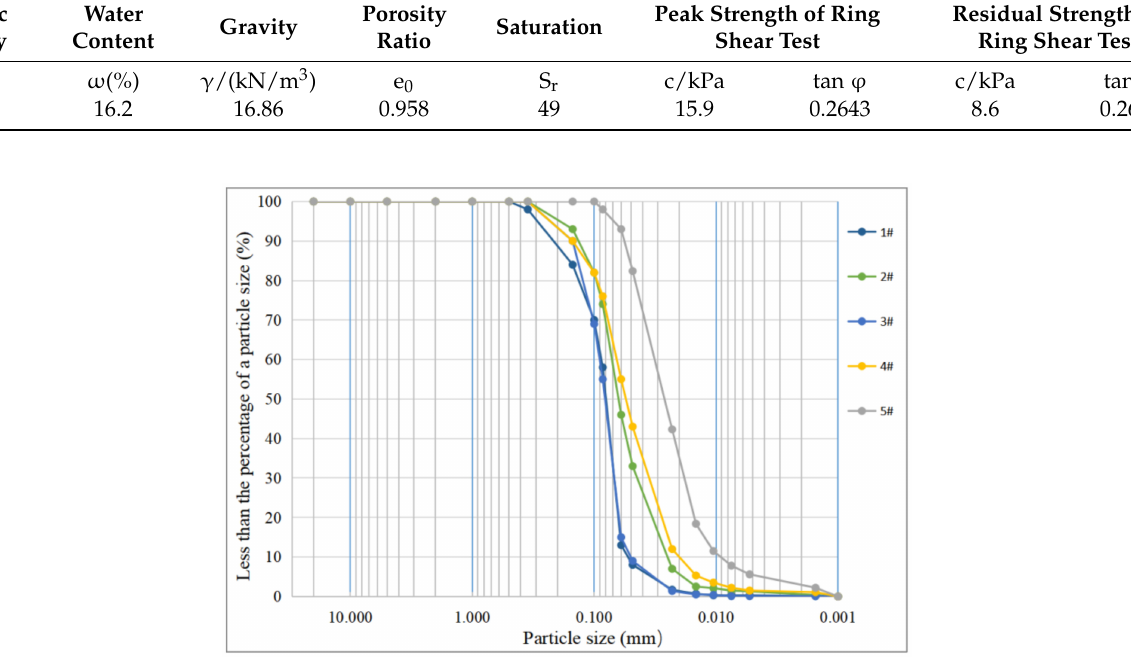
Figure 4. Tailing sand particle size gradation